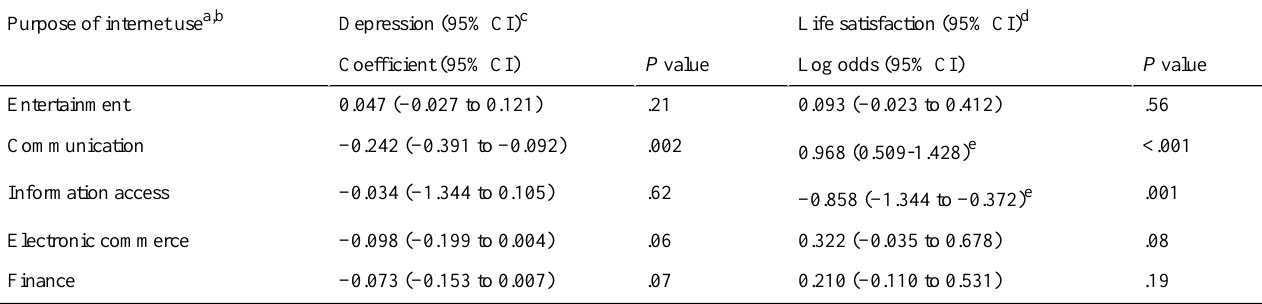
Table 3. Random effects model coefficients for the purpose of internet use on mental health